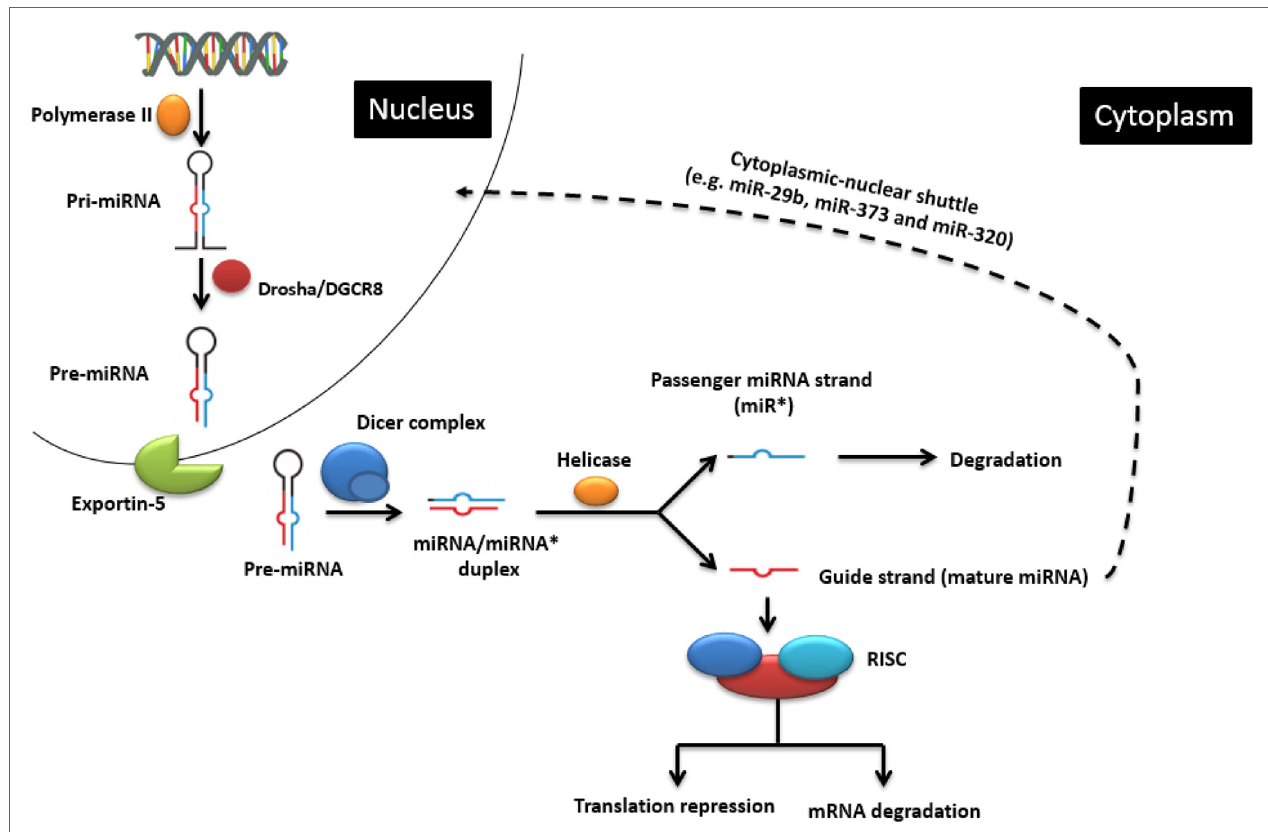
FiGURe 1 | The classic endogenous miRNA pathway and mechanisms of action . In the nucleus, pri-miRNA is transcribed by RNA polymerase II and further processed by the Drosha enzyme to produce pre-miRNA, which is then transported into the cytoplasm. There it is cleaved by the Dicer enzyme into the miRNA duplex. The guide strand is uploaded onto the RNA-induced silencing complex (RISC) to regulate gene expression by causing either target mRNA degradation or translation repression. Cytoplasmic-nuclear shuttle is possible for some miRNAs (e.g., miR-29b, miR-320, and miR-373). Adapted from Wikimedia Commons (“Difference DNA